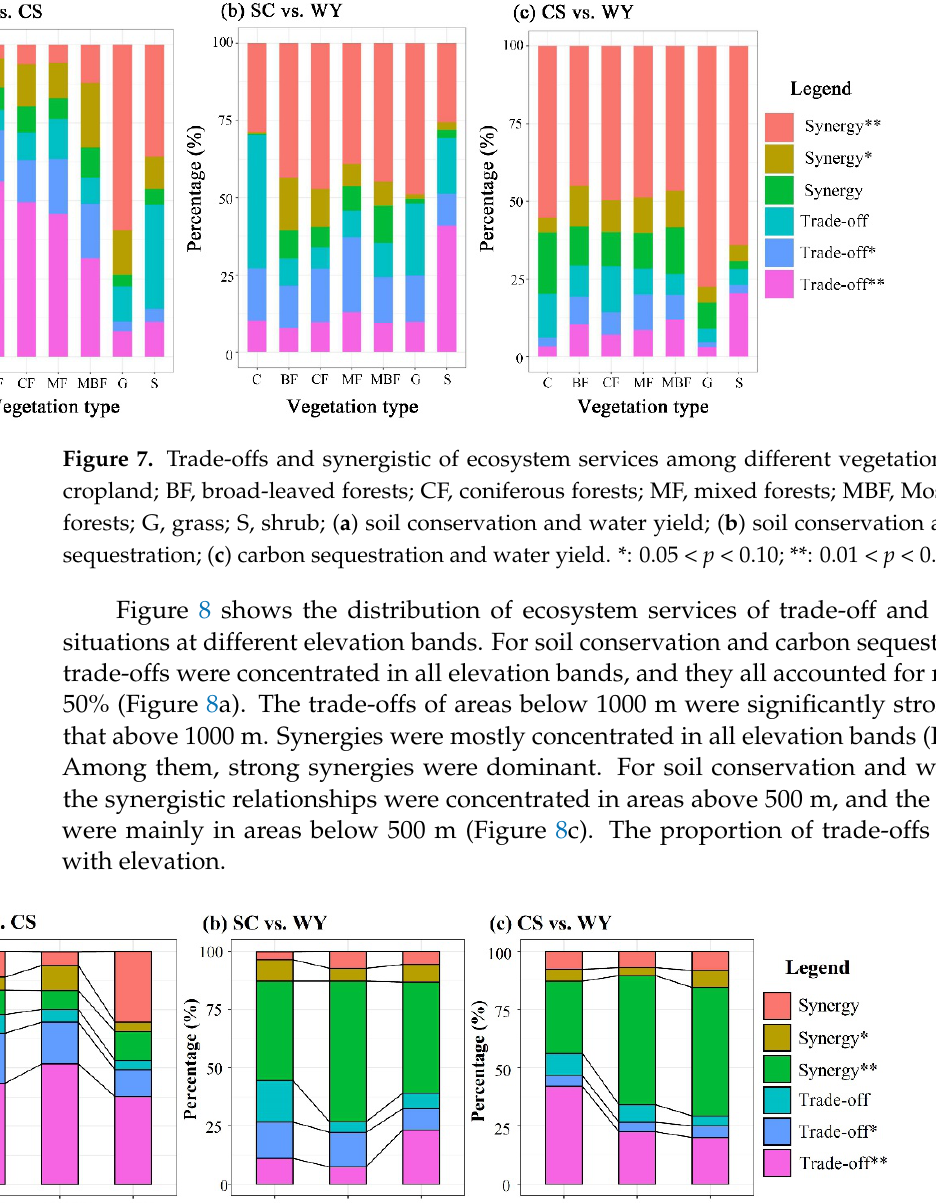
Figure 8. Trade-offs and synergistic of ecosystem services at different elevation bands; ( a ) soil conservation and water yield; ( b ) soil conservation and carbon sequestration; ( c ) carbon sequestration and water yield. *: 0.05 < p < 0.10; **: 0.01 < p < 0.05.